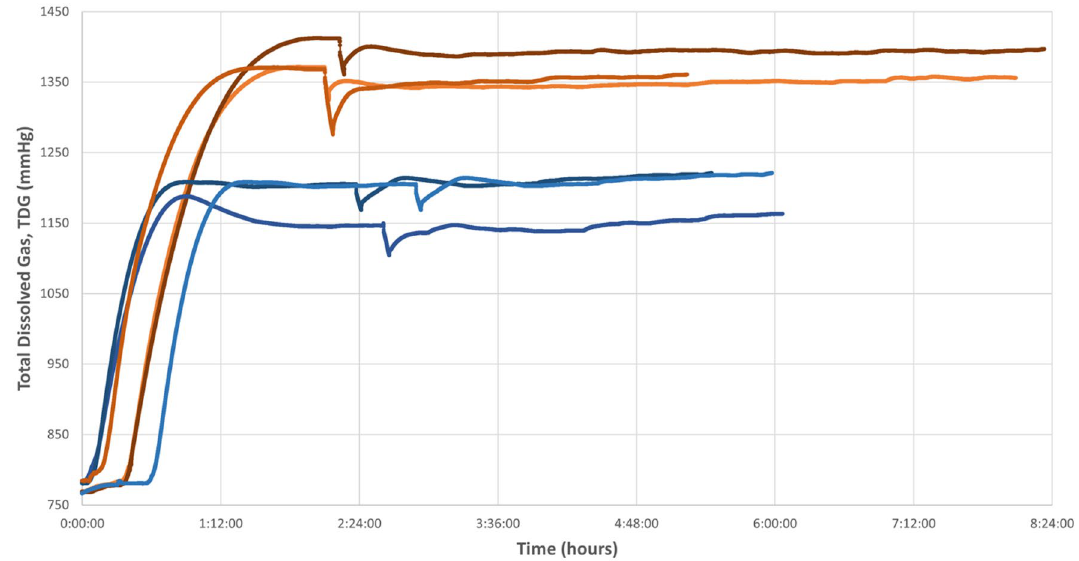
Figure 4. TDG plots represent the pilot tests without fish. The orange lines represent the group in which a high TDG value (180%) was reached, while the blue lines represent the experiments with a TDG of approximately 150%. The peaks observed in the different tests represent the simulation of fish introduction.